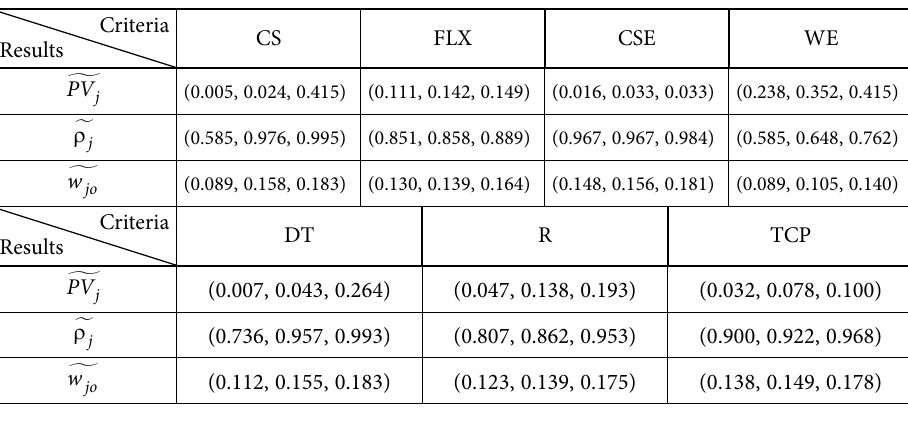
Table 10. The results of fuzzy